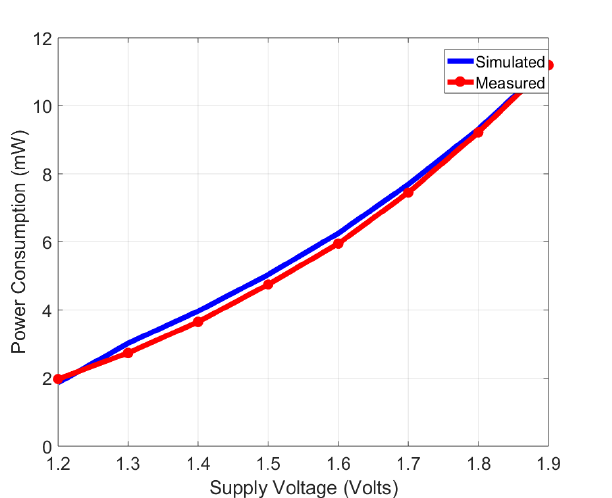
Figure 14. Power-consumption versus voltage supply for the unoptimized IR-UWB Transmitter at 50 Mbps data rate with fixed 1 k Ω resistance for current